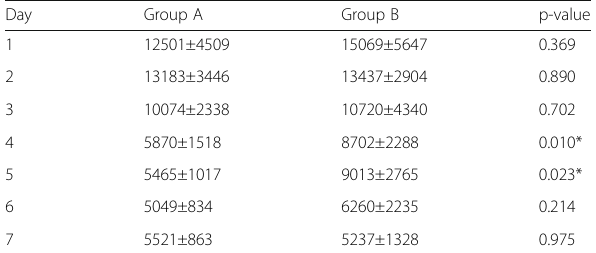
Table 94 (abstract A299). Daily intravenous fluids in the 1st week